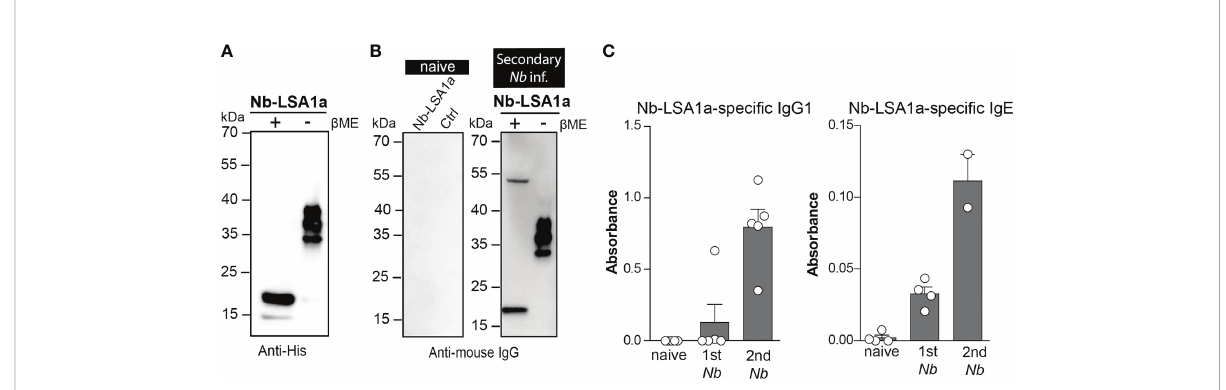
FIGURE 3 Native Nb-LSA1a forms oligomers and is detectable by serum IgG1 and IgE from secondary Nb -infected mice. (A) Detection of puri fi ed His- tagged Nb-LSA1a from supernatant of transfected HEK293T cells after SDS-PAGE under reducing (+) and non-reducing (-) conditions and Western blot using an anti-His-tag antibody. (B) Supernatant of HEK293T cells expressing Nb-LSA1-His or empty His vector (Ctrl) was analyzed by standard SDS-PAGE under reducing (+) and non-reducing (-) conditions and Western blotting with serum from naïve (left) or secondary Nb- infected mice (right), following by detection with an anti-mouse IgG antibody. (C) Detection of Nb-LSA1a-speci fi c IgG1 (left) and IgE (right) in serum from naïve, primary (1st) or secondary (2nd) Nb- infected mice. Bars show the mean+SEM with 4-5 mice per